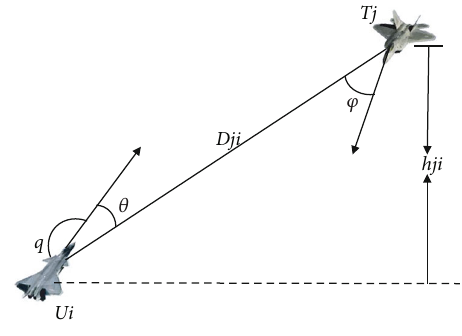
Figure 2: Air combat situation